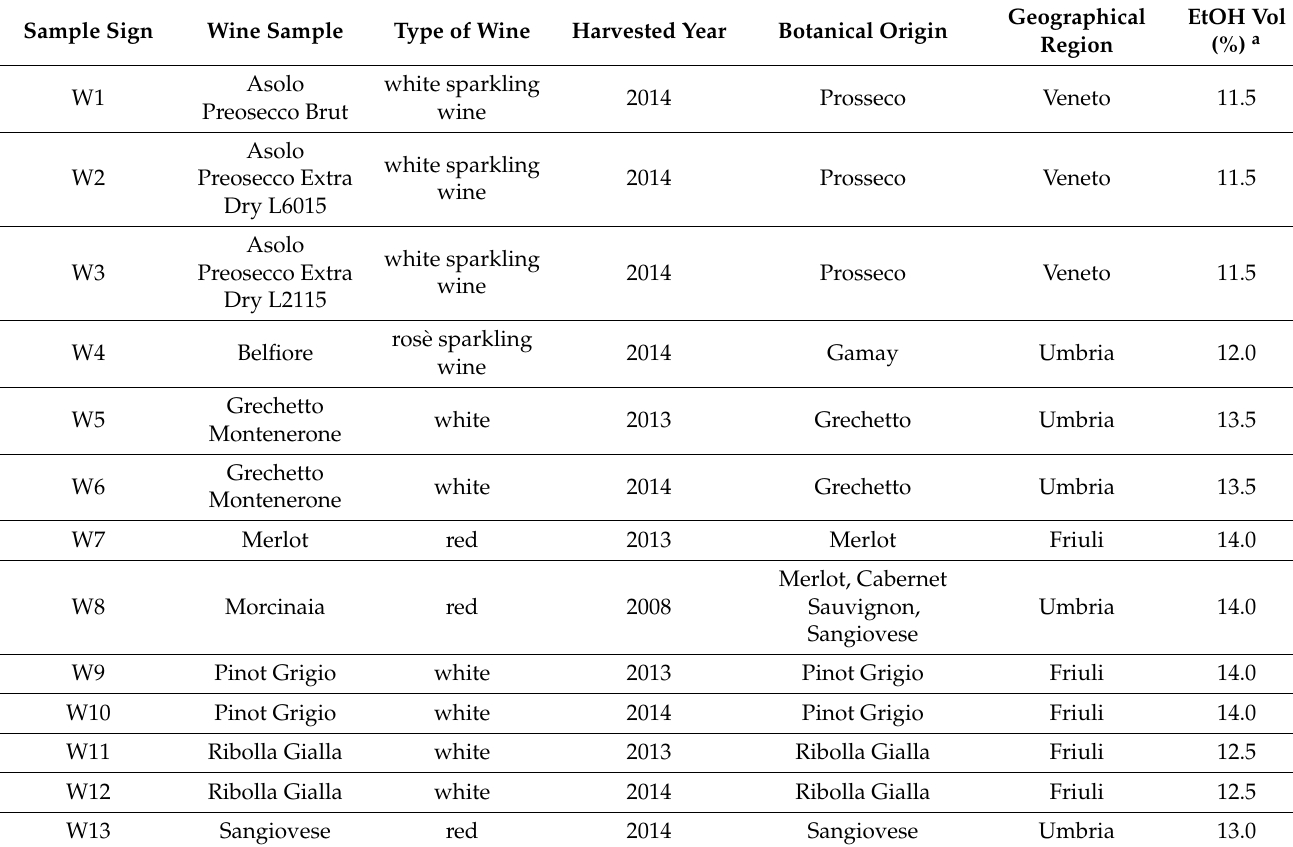
Table 1. Analyzed wine samples; the different characteristics are reported for each